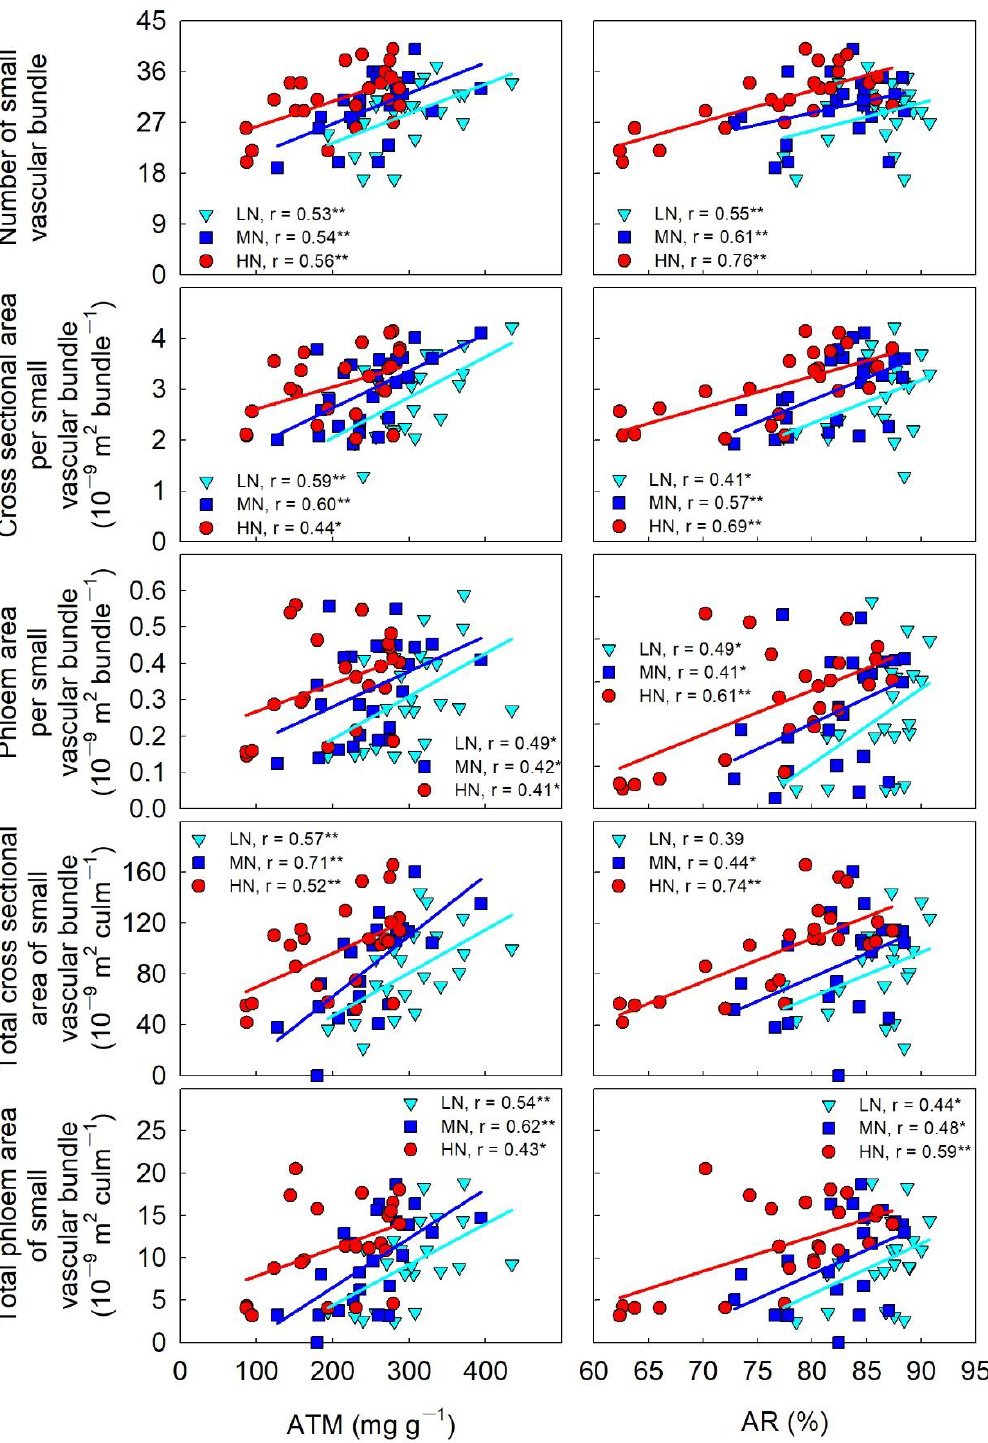
Figure 9. Correlations of SVB-related traits with stem ATM and AR. * and **, significant at p < 0.05 and at p < 0.01, respectively. LN, low nitrogen; MN, medium nitrogen; HN, high nitrogen; ATM, apparent transferred mass; AR, apparent transferred ratio.